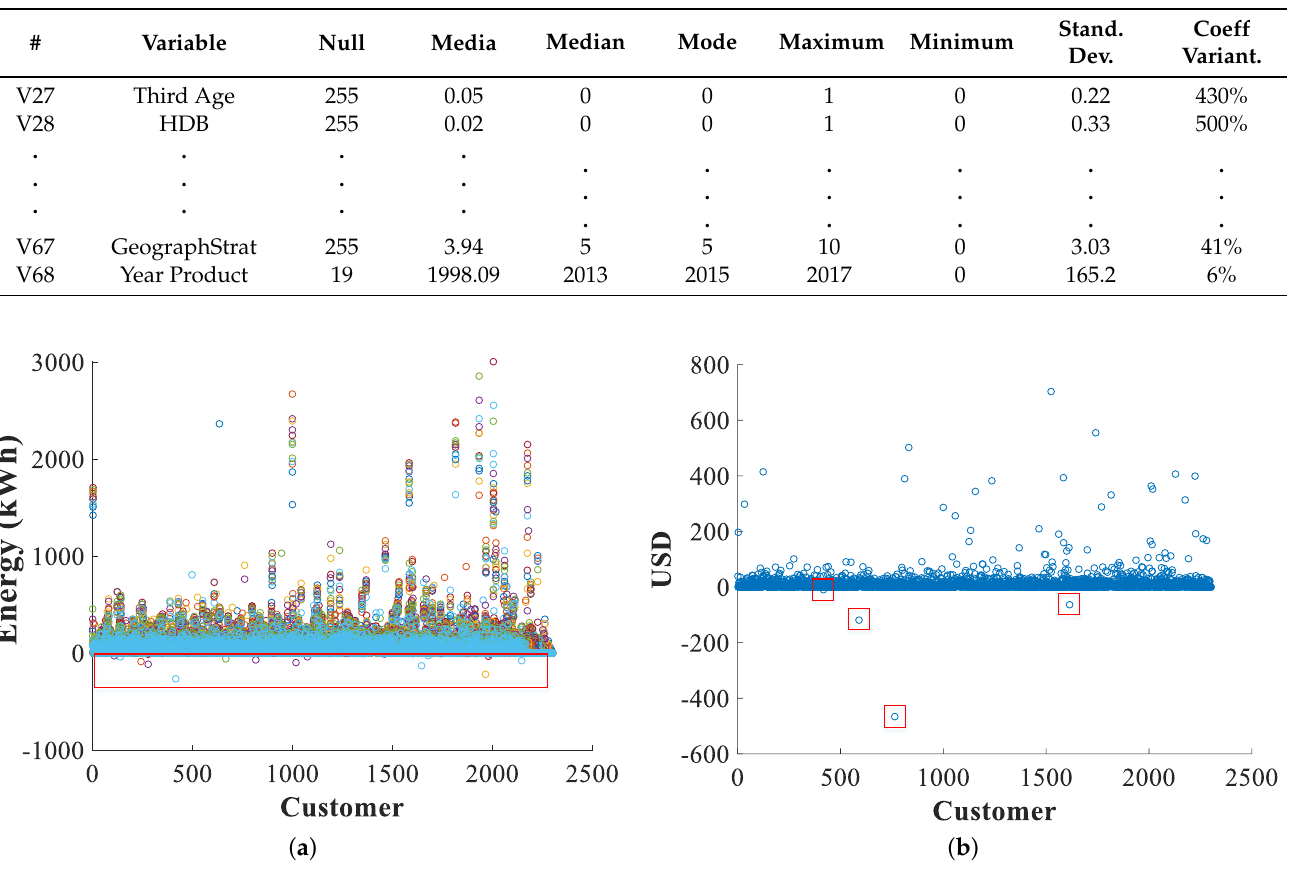
Figure 3. ( a ) Data dispersion of the energy consumption variable; ( b ) Data dispersion of the debt